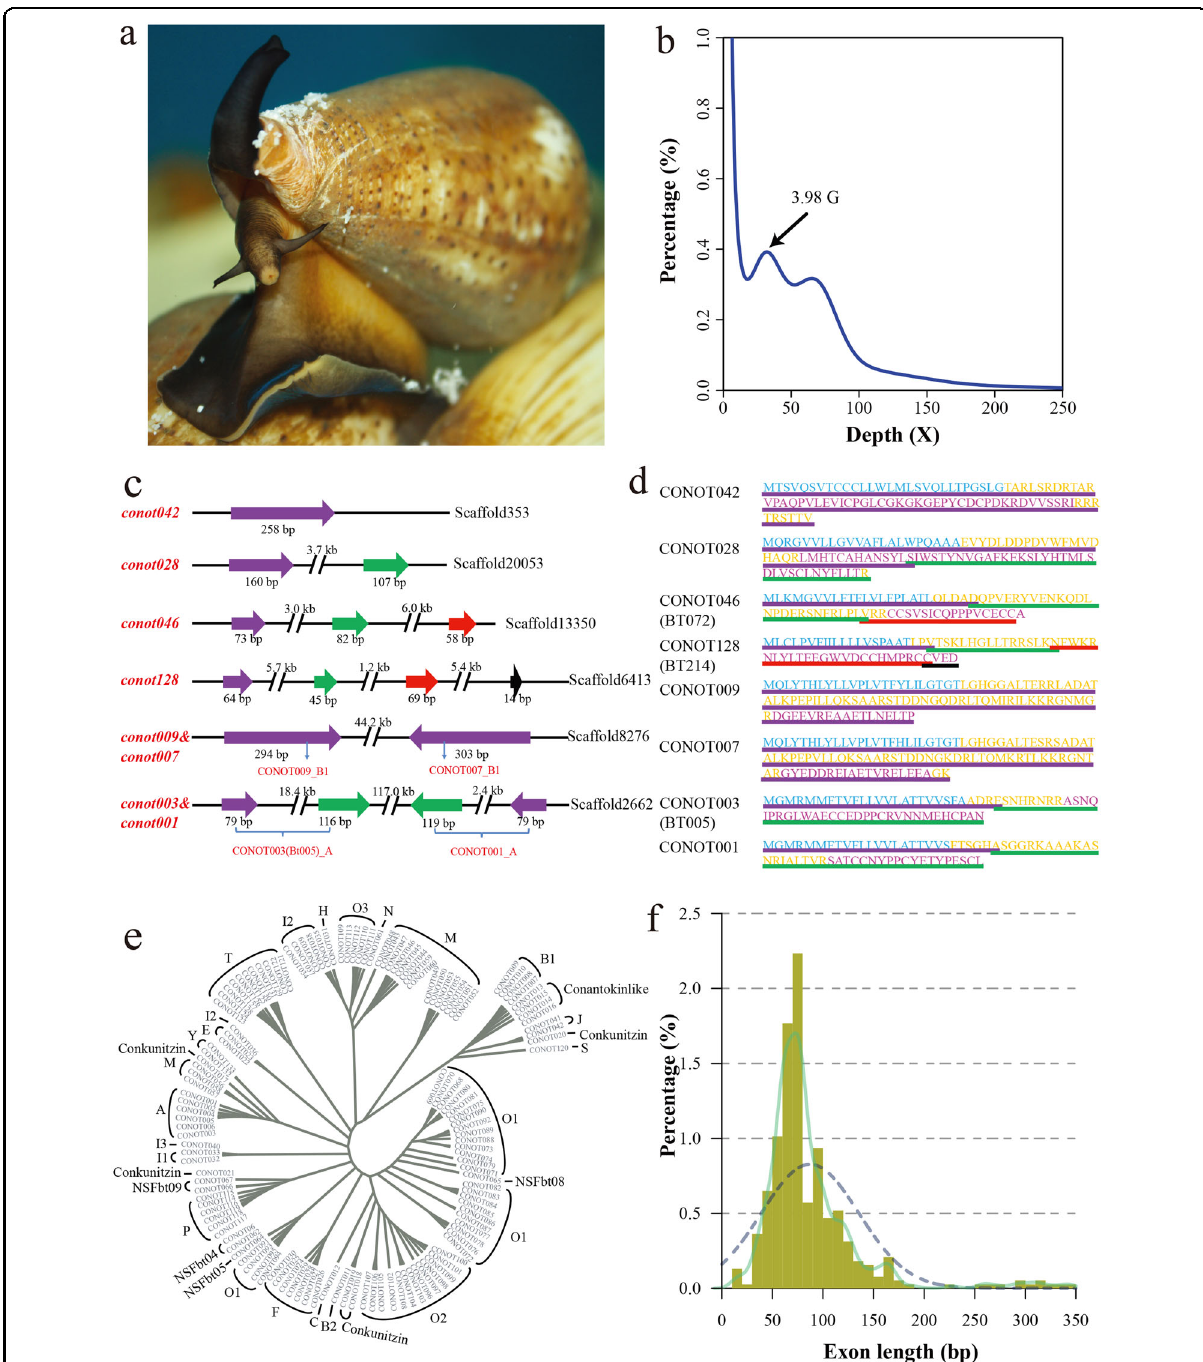
Fig. 1 Identi fi cation of 133 conopeptide genes from the assembled genome of C. betulinus . a Image of a representative C. betulinus . b The 17- mer distribution of sequenced reads. These sequencing data generated from the Illumina short-insert libraries were used for a genome survey analysis 8 . The x -axis represents the sequencing depth of each 17-mer, and the y -axis represents the percentage of each unique 17-mer. c Four representative types of exon distribution in the identi fi ed full-length conopeptide genes. Regions in purple, green, red, and black stand for the 1st, 2nd, 3rd, and 4th exons, respectively. d Eight deduced protein sequences of these genes in c . Sequences highlighted in black, yellow, and red are signal peptides, pro-/post-peptides and mature peptides of these precursors, respectively. e Phylogeny of identi fi ed conopeptide genes based on predicted signal peptide sequences. f Detailed distribution of exon